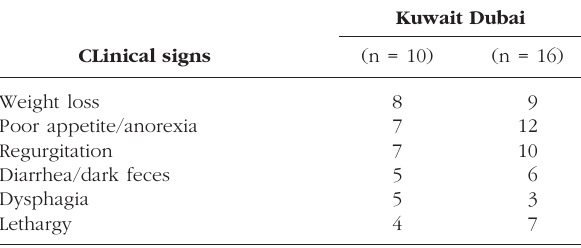
Table II. – Clinical signs of capillariosis in